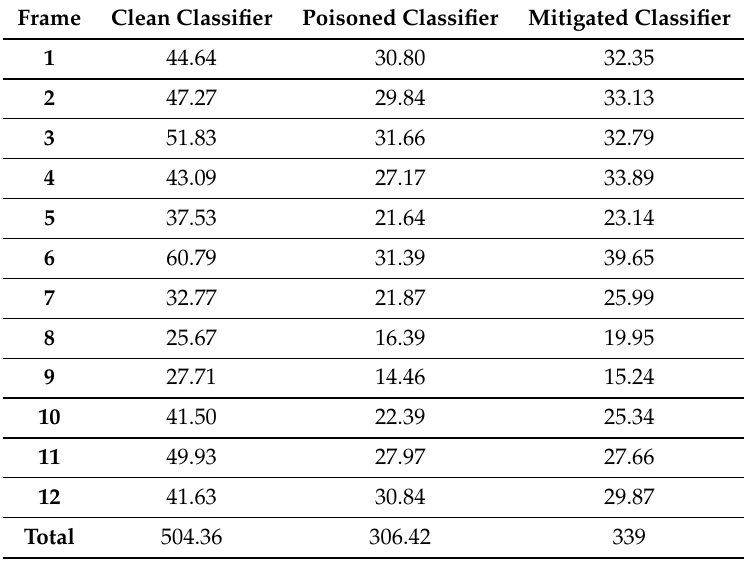
Table 9. Classifiers’ Training Time (Seconds) for Dynamic Relabeling Adversarial